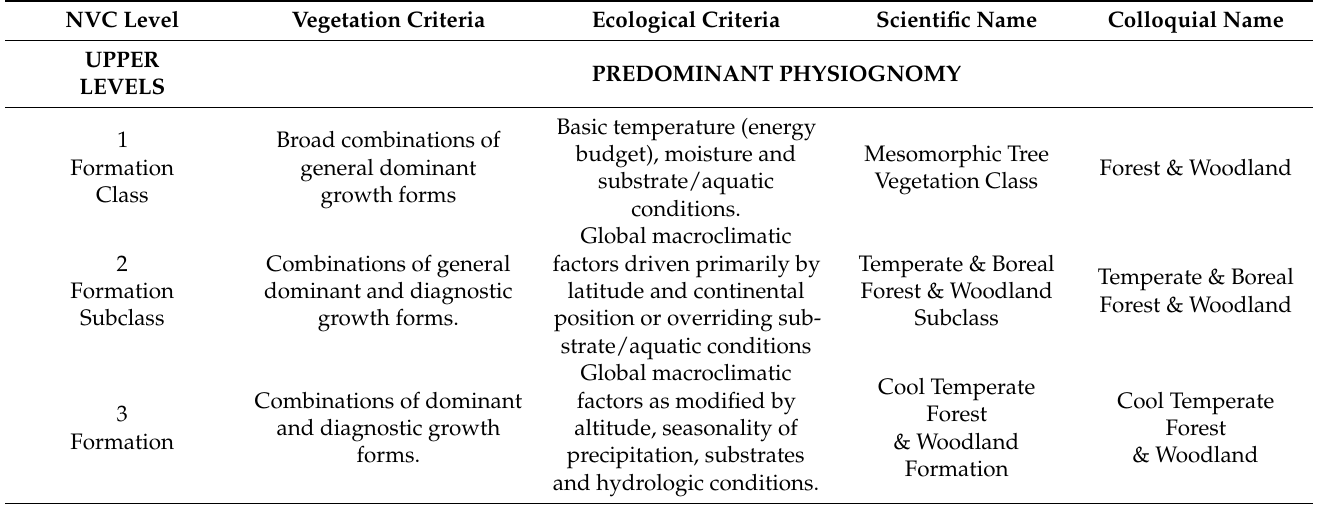
Table 1. U.S. National Vegetation 8-level hierarchy, criteria, and example types at each level. For these analyses we focused on the Formation Class and the Group levels of the hierarchy